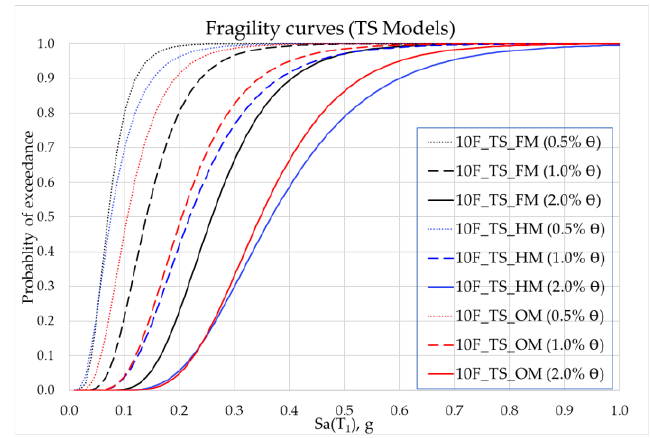
Figure 7. Fragility curves of trimmed section models.